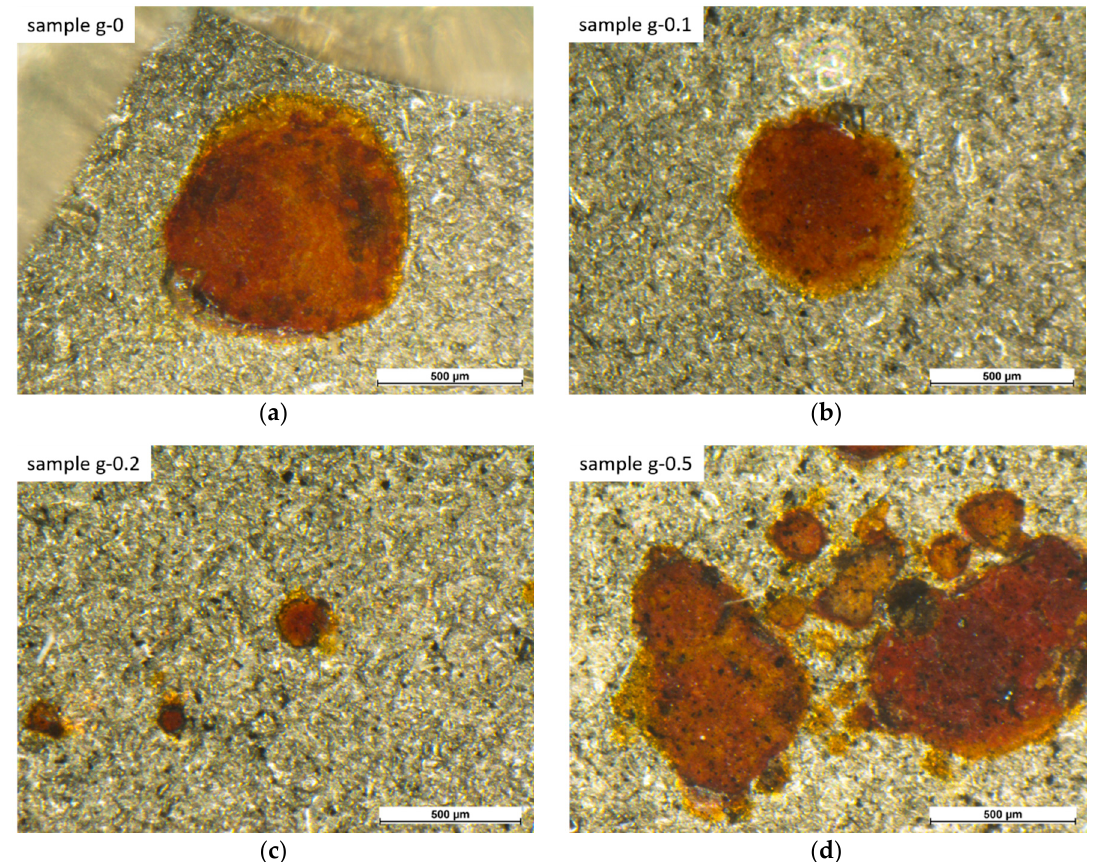
Figure 5. Optical stereomicroscope observations of the blister at the end of the AC–DC–AC test. ( a ) sample g ‐ 0; ( b ) sample g ‐ 0.1; ( c ) sample g ‐ 0.2; ( d ) sample g ‐ 0.5.